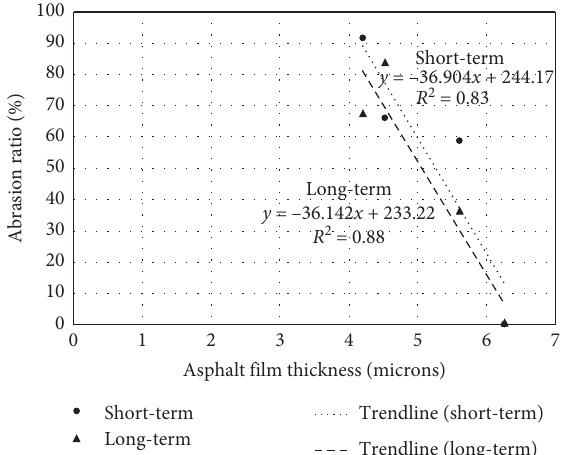
Figure 10: Correlation between the abrasion ratio and asphalt film thickness for short- and long-term performance.